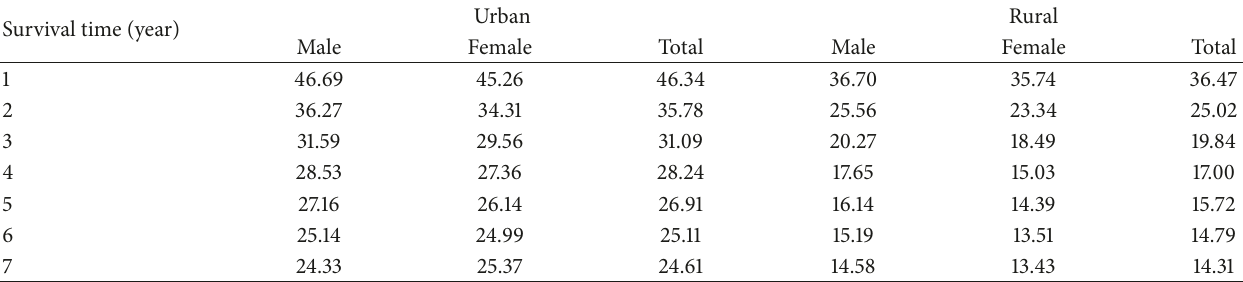
Table 3: Relative survival rate of liver cancer in Zhejiang province from 2005 to 2010 (%).